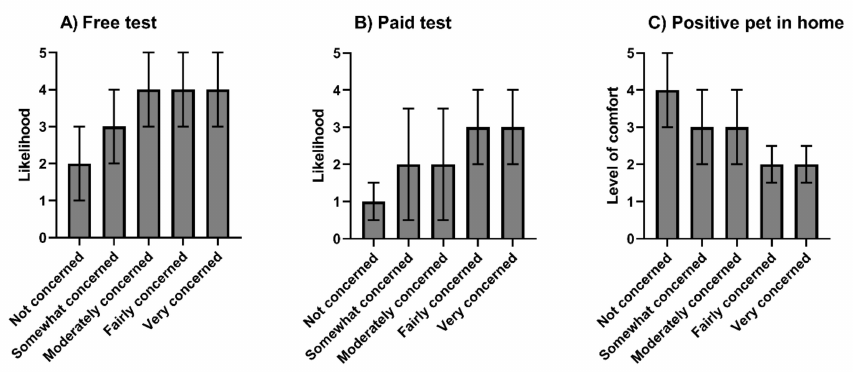
Figure 2. Concern about contracting COVID-19 relative to: ( A ) the likelihood of getting a pet tested for SARS-CoV-2 in the test were free; ( B ) the likelihood of getting a pet tested for SARS-CoV-2 if there was a fee; and ( C ) the level of comfort with having a SARS-CoV-2-positive pet in the home. Data are shown as the median ±